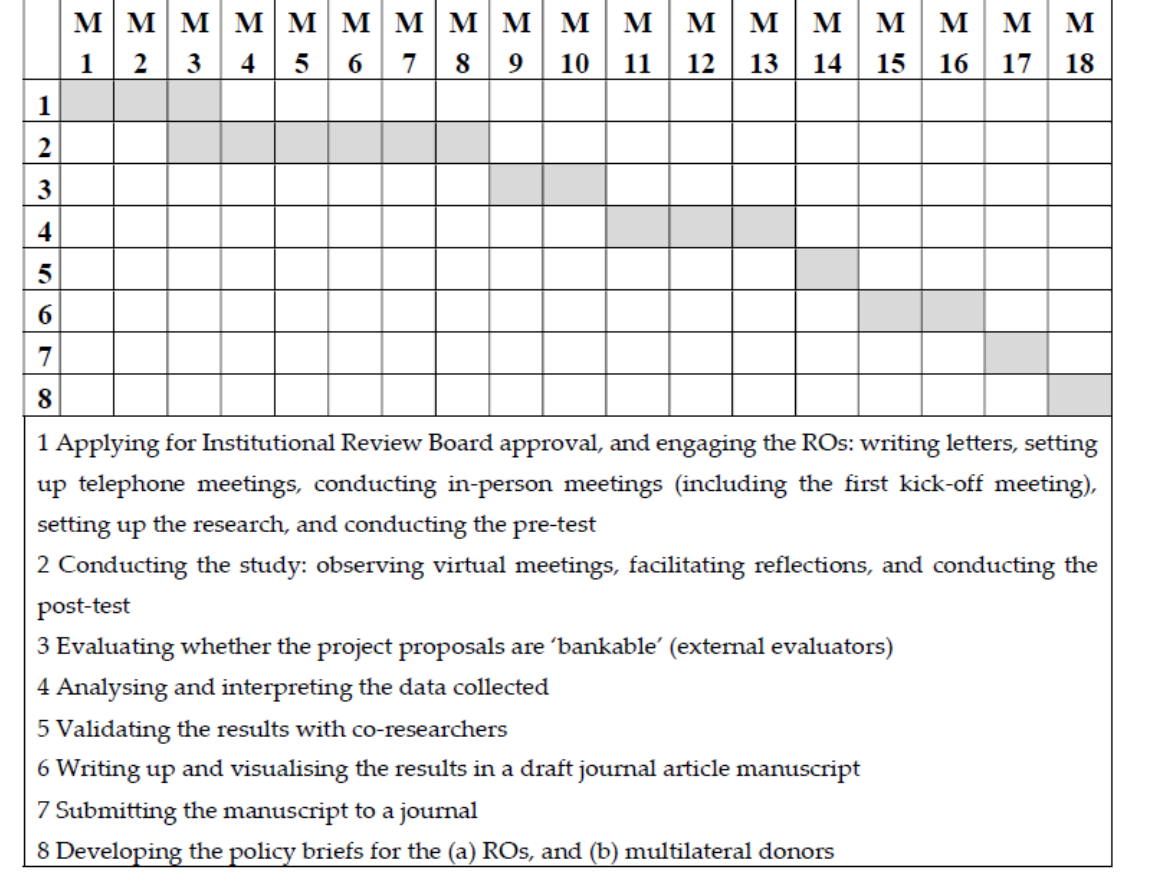
Figure 4. Calendar / project implementation schedule over 18 months (source: Figure 4. Calendar/project implementation schedule over 18 months (source: authors).